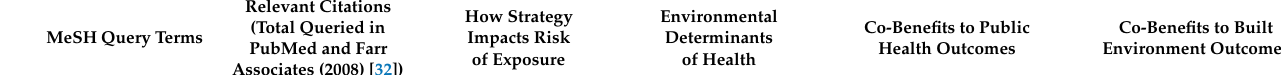
Table 3. Association between LEED credits and community resilience to urban flooding events: A review of the evidence.